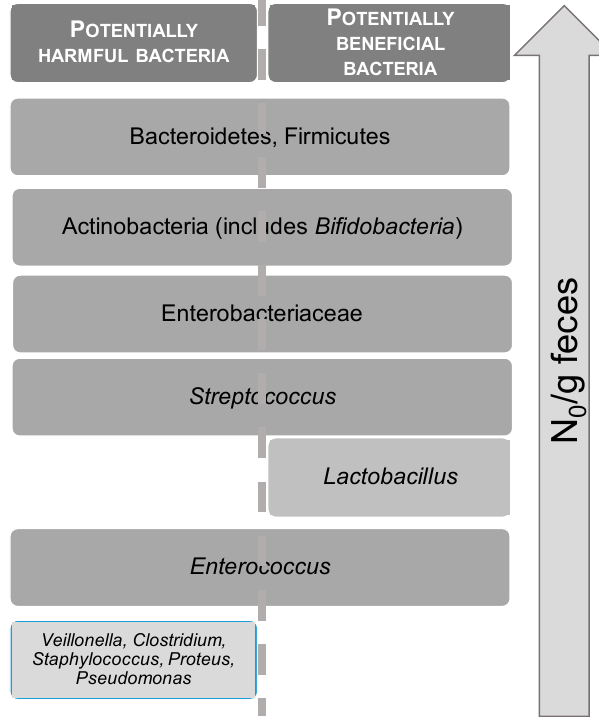
Figure 4. Beneficial bacteria and suppressing pathogenic microorganism.